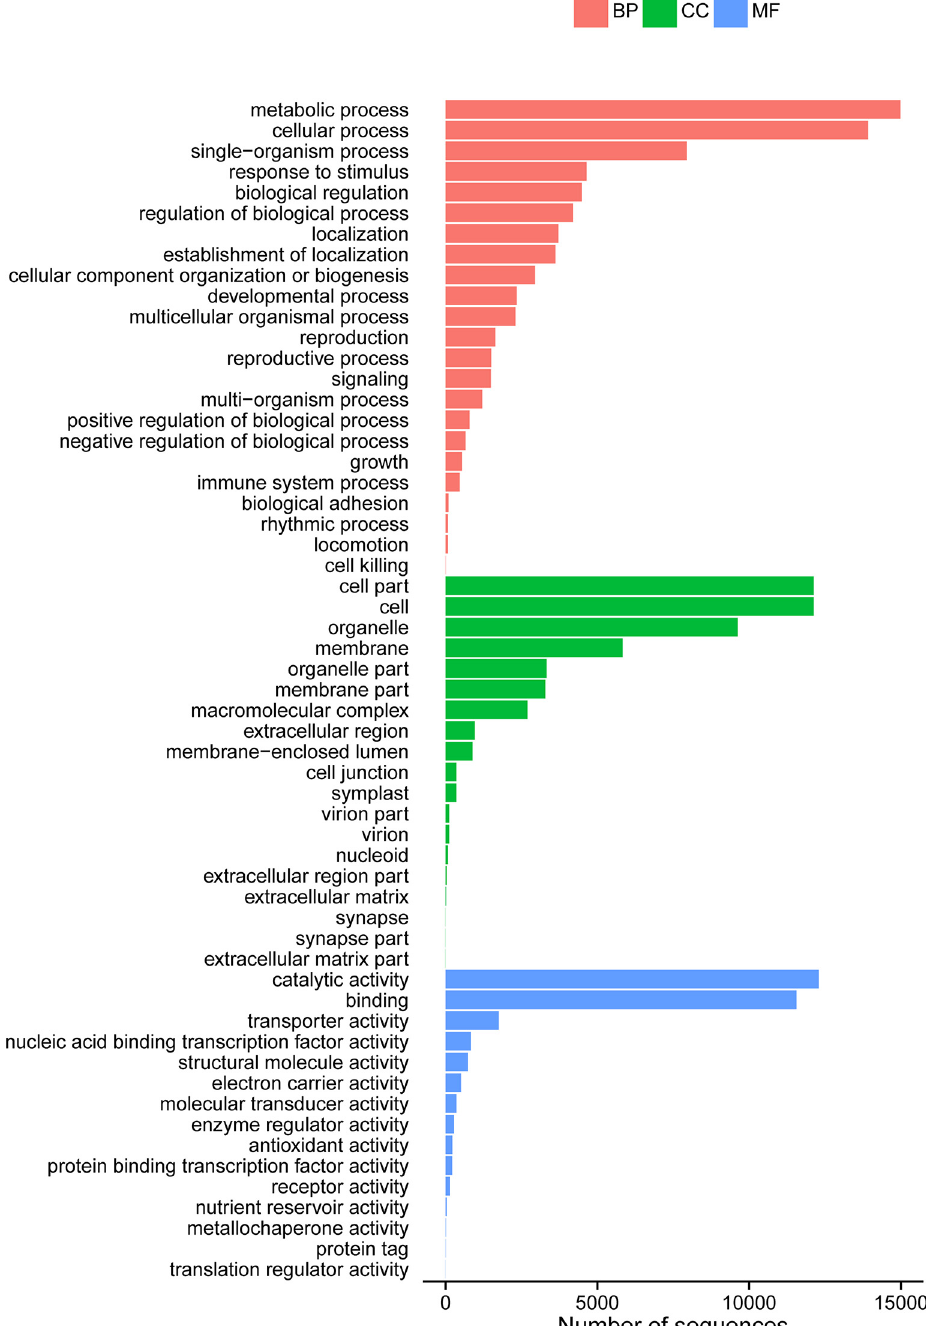
Fig 3. Histogram of the gene ontology classifications of annotated unigenes from the W . ugandensis transcriptome. BP, Biological process; CC, Cell component; MF, Molecular function. (Fig 5). In the first group, seven TPSs (WuSps1-7) are likely to be involved in sesquiterpene biosynthesis, which are clustered with two available W . ugandensis TPSs sequences (WargTPS-c, ACJ46047.1; WargTPS-g, ACJ46048.1) and a β -cubebene synthasefrom Magnolia grandiflora